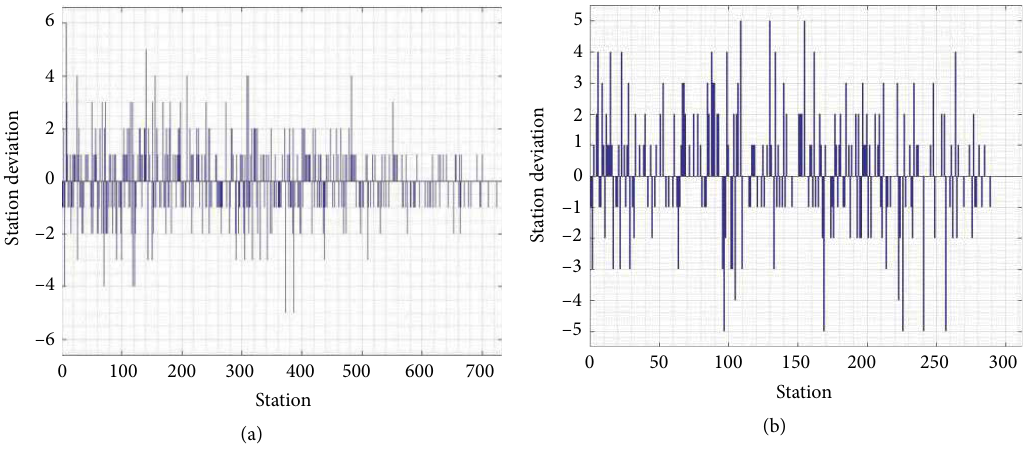
Figure 15: The daily deviation of station 𝑖 for 𝐸 & 𝐺